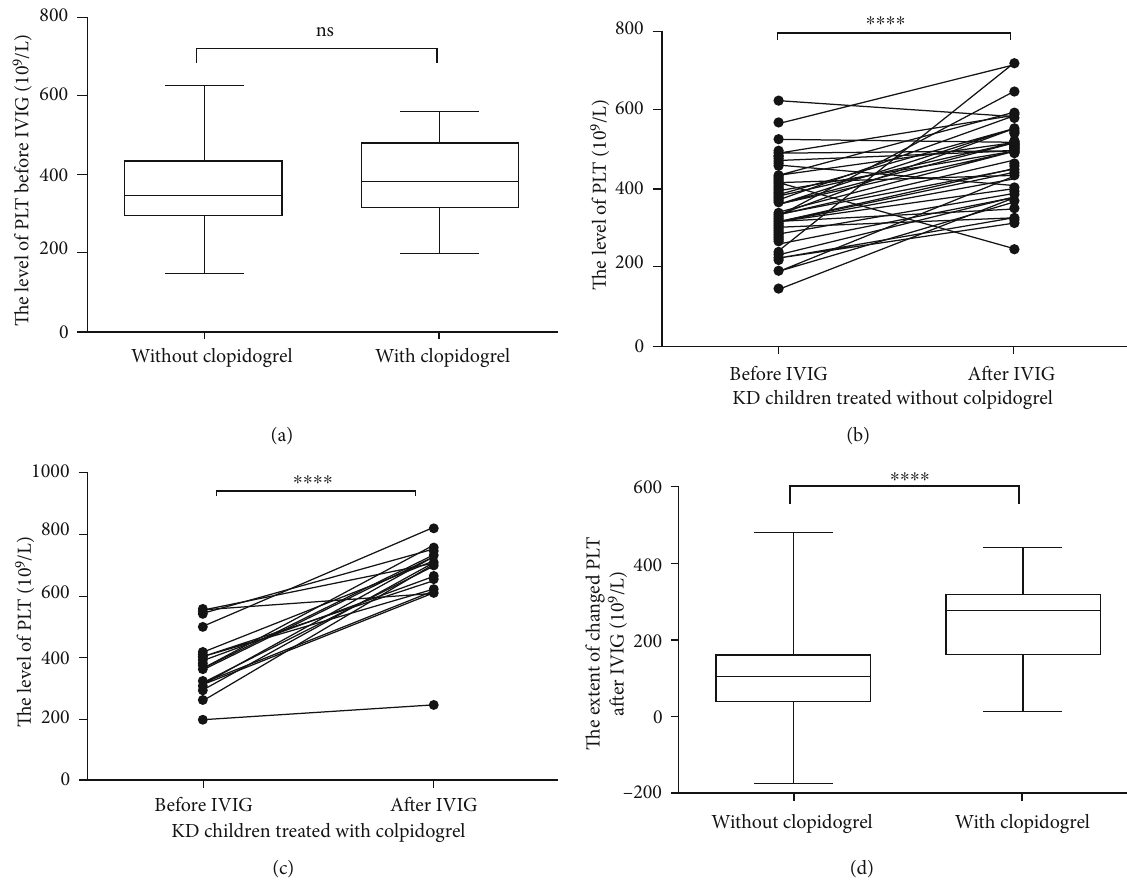
Figure 4: Altered PLT count in children with KD treated with or without clopidogrel. (a) Before IVIG, there was no obvious di ff erence between the children with KD treated with and without clopidogrel. (b) In children with KD treated without clopidogrel, the PLT count markedly increased after IVIG. ∗∗∗∗ P < 0 : 0001 . (c) In children with KD treated with clopidogrel, the PLT count markedly increased after IVIG. ∗∗∗∗ P < 0 : 0001 . (d) After IVIG, the extent of the increase of the PLT count in children with KD treated with clopidogrel was markedly higher than that in children with KD treated without clopidogrel. ∗∗∗∗ P < 0 : 0001